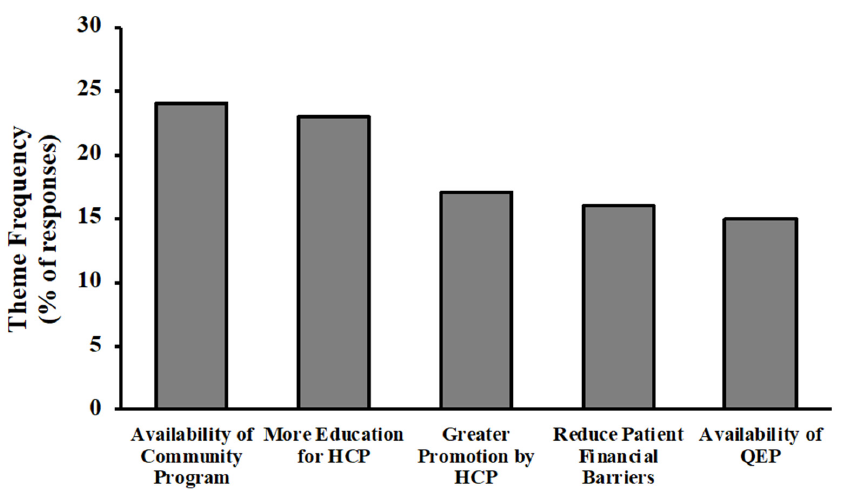
Table 1. Participant characteristics and physical activity counselling or exercise prescription practices across physicians, nurses, dietitians, and exercise professionals.